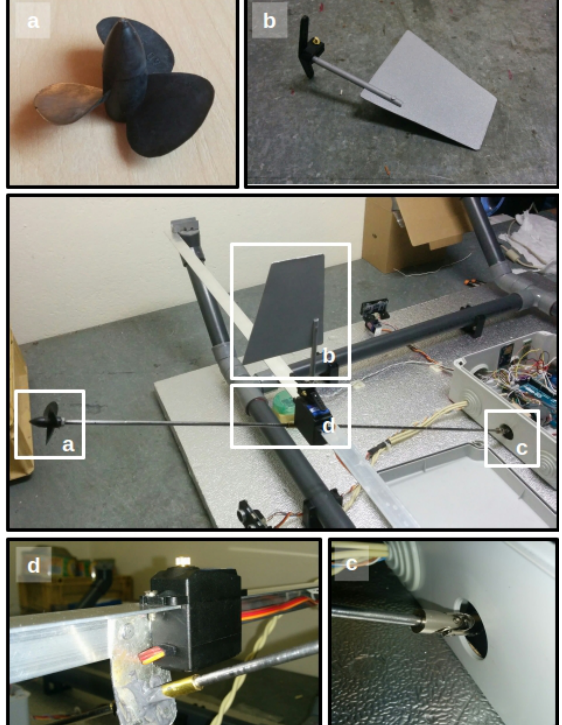
Figure 8. Main mechanical elements for propulsion and direction: ( a ) 3-blade propeller; ( b ) Rudder; ( c ) steel transmission shaft; ( d ) and waterproof servo for rudder